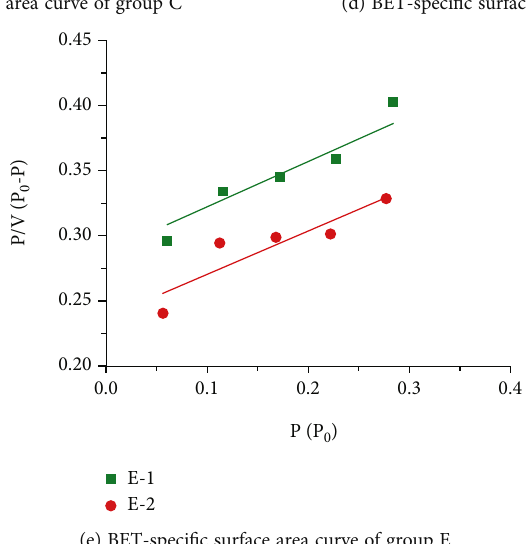
(c) BET-speci fi c surface area curve of group C (d) BET-speci fi c surface area curve of group D